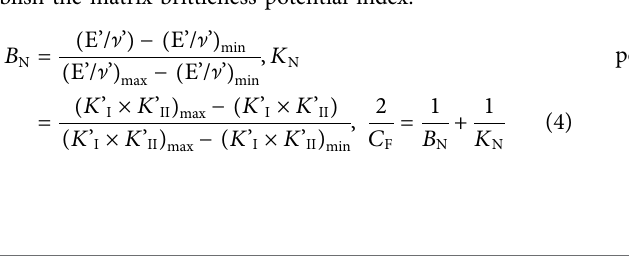
Frontiers in Earth Science |